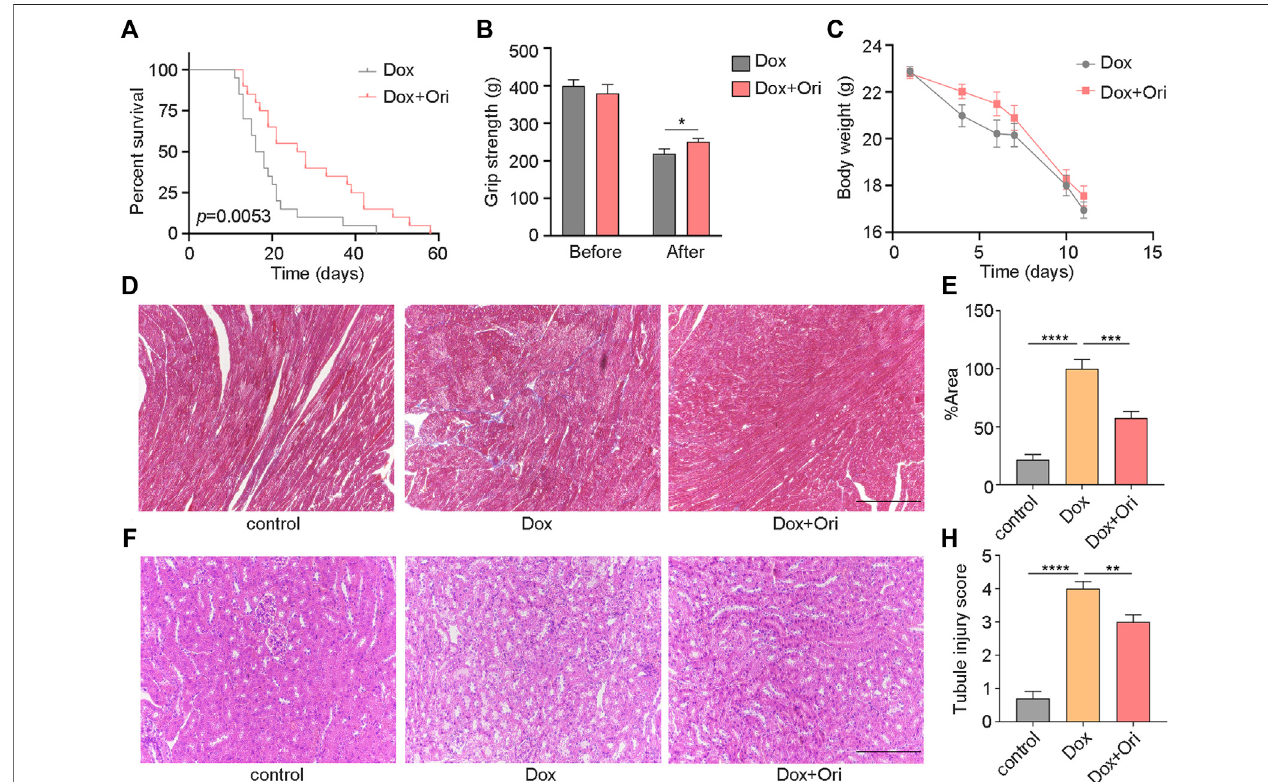
FIGURE 5 | Oridonin prolongs the lifespan and healthy lifespan of premature aging mice. (A) Oridonin (Ori) (2 mg/kg) prolongs the lifespan of mice with premature aging induced by doxorubicin (model n = 19, oridonin 2 mg/kg n = 10, P= 0.0053). (B) The mouse grip test (left) before the doxorubicin model and oridonin (Ori) intervention,andthemousegriptest(right)2 weeksafterthedoxorubicinmodelandoridonin(Ori)intervention( n =12 – 20). (C) Doxorubicin-inducedsenescenceinmice, and body weight wasdetected under the intervention oforidonin (Ori) ( n = 12 – 20). (D – E) Masson ’ s trichrome stainingwas used todetect the cardiac morphology, fi brosis and quanti fi cation ofmice inthecontrolgroup, doxorubicin-induced agingand oridonin(Ori) intervention groups ( n =6per group), Bar =100 µm. (F) HE staining to detect the kidney morphology of mice in the normal control group, doxorubicin-induced aging and oridonin (Ori) intervention groups ( n = 6 per group), Bar = 100 µm. (H) Kidneyinjuryscore( n =6pergroup).Datarepresentthemean±SEM. p valuesweredeterminedbyone-wayANOVA,Student ’ s t-test or.Log-rank(Mantel-Cox)test. (* p < 0.05, ** p < 0.01, *** p < 0.001, **** p < 0.0001).